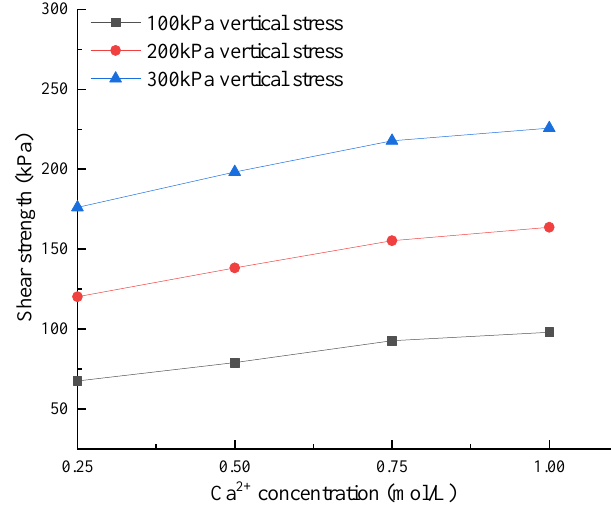
Figure 4. Shear stress variation with calcium ion concentration.